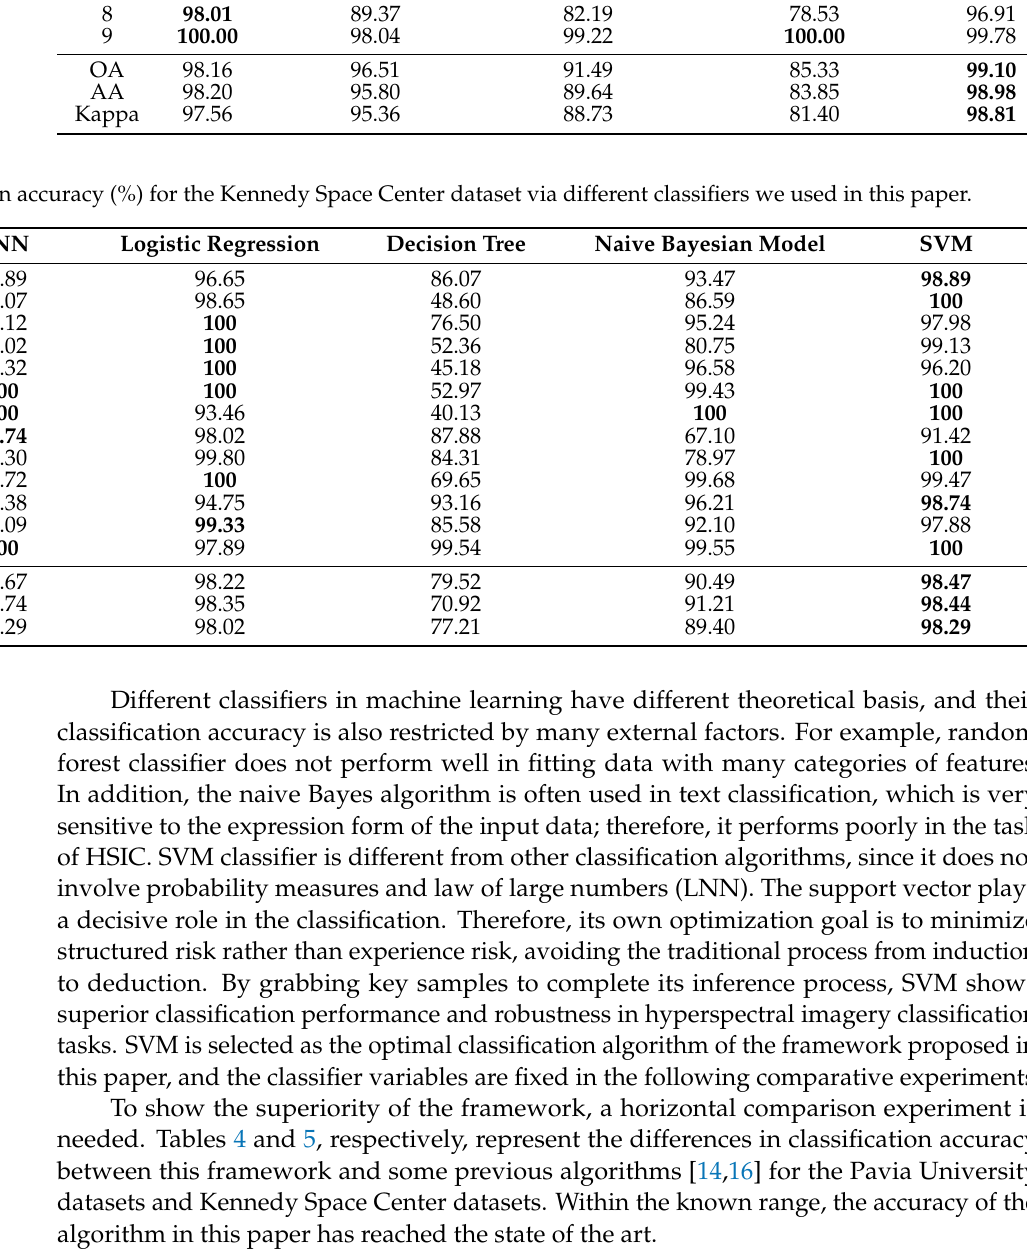
Table 2. Classification accuracy (%) for the Pavia university dataset via different classifiers we used in this paper.